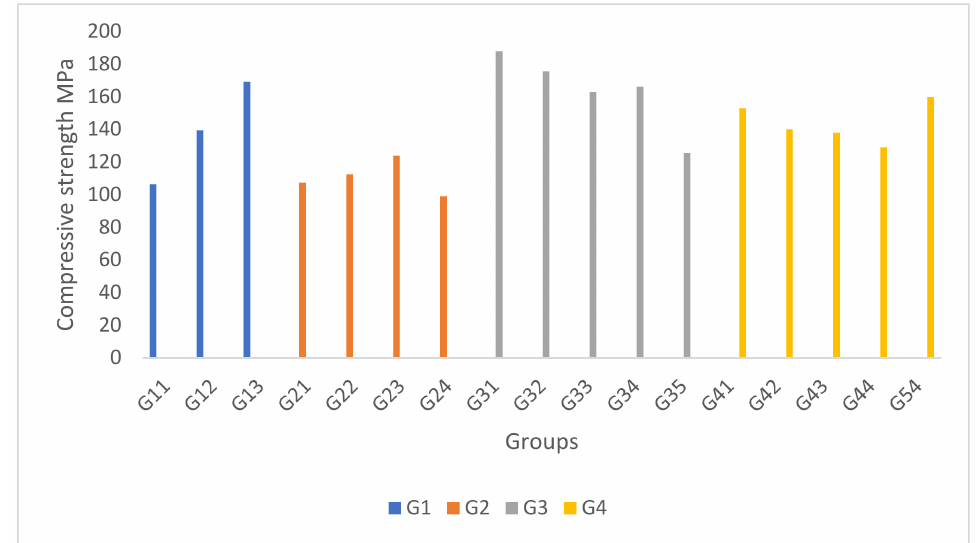
Figure 2. Compressive strength of the hybrid GFRP